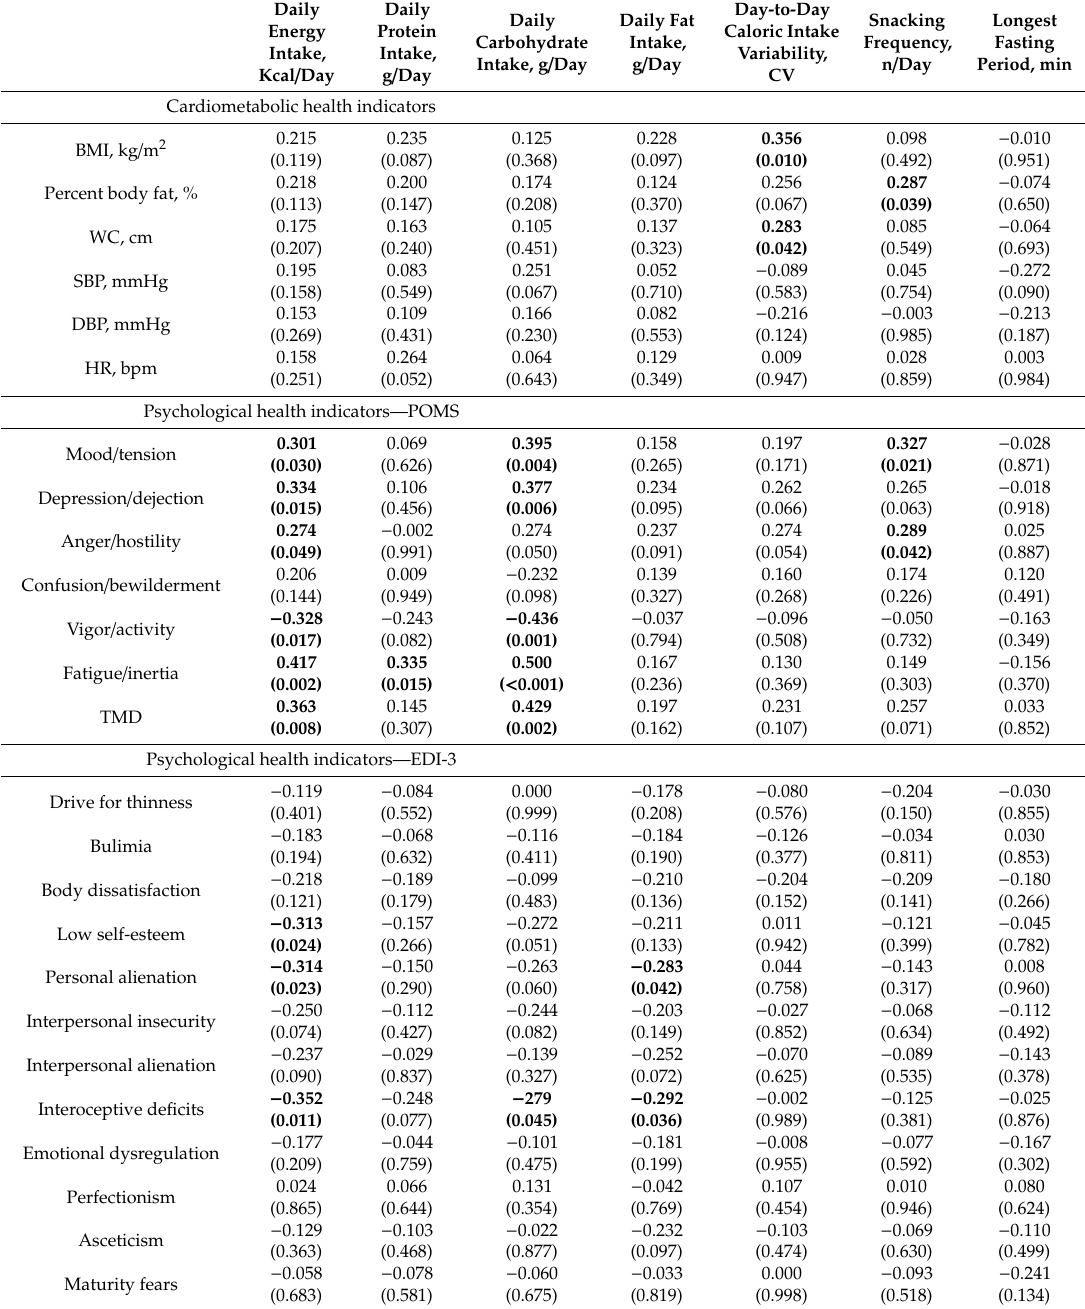
Table 2. Correlations between dietary intake and cardiometabolic and psychological health indicators. Daily